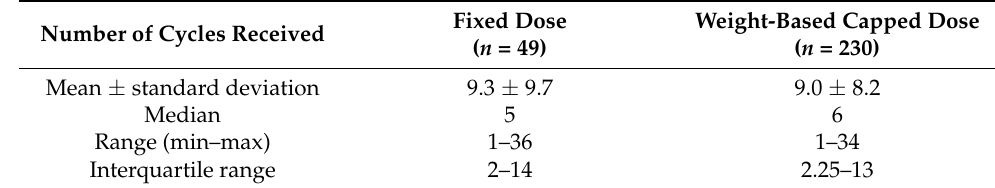
Table 3. Number of pembrolizumab cycles received as of 29 February 2020 as per dosing strategy.